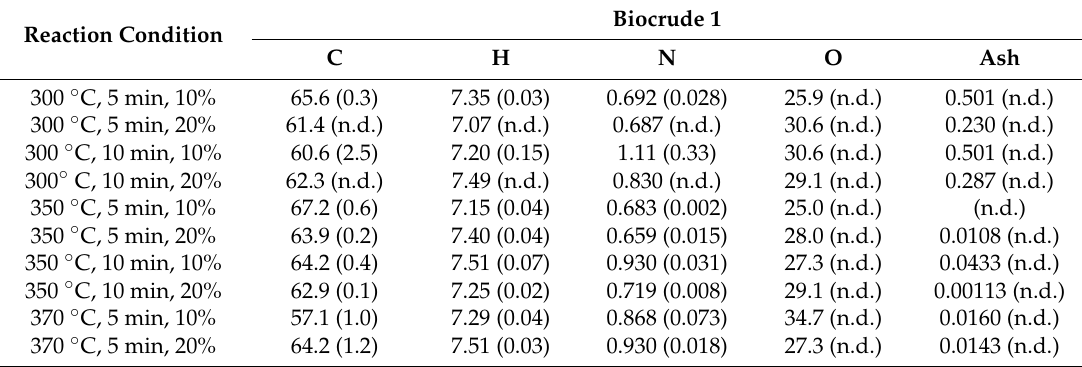
Table A3. Elemental composition of light biocrude fraction (% w / w , as received). Absolute standard deviation, where available, is reported in brackets.